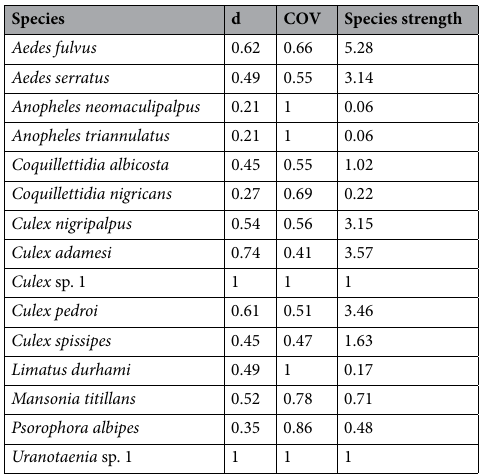
Table 2. Index values of specialization by mosquito species recognized in San Juan, Carare, Colombia. The Specialization index (d) and the Coefficient of interaction variation (COV) are estimated with scaled values between 0 to